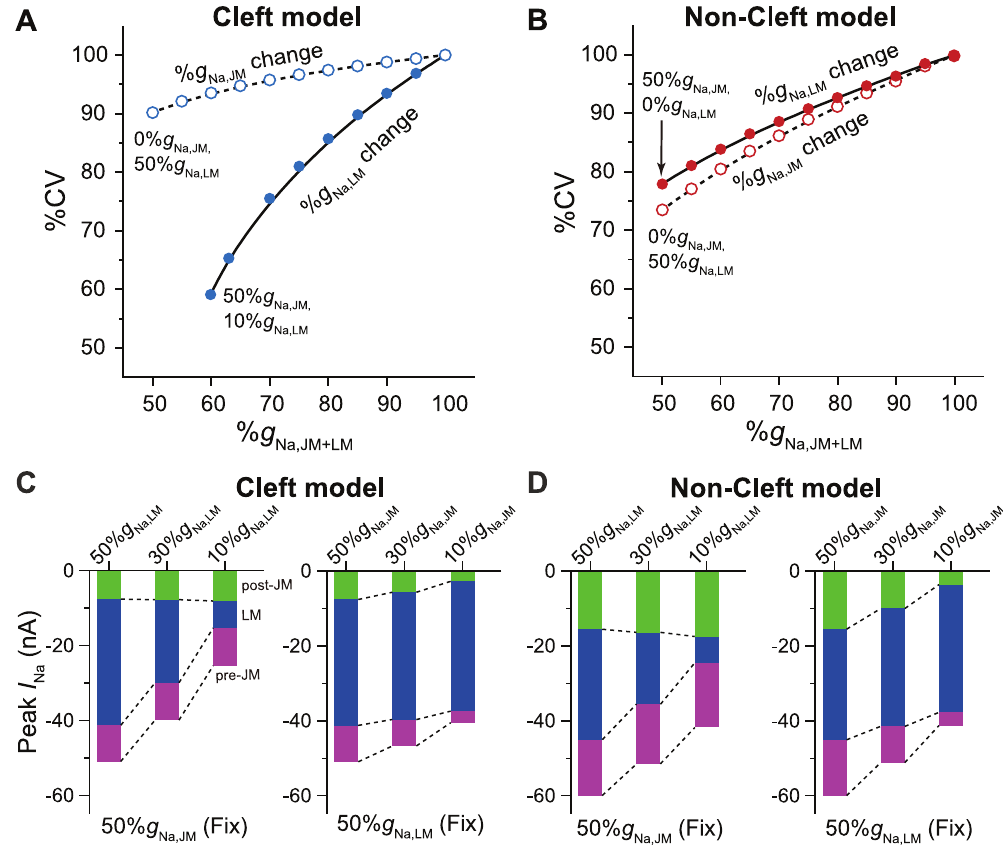
Figure 2. Conduction velocities and changes in regional I Na in cardiomyocytes in each myofiber model. (A) and (B), Relative ratios of CV (%CV) normalized by CV in the myocardial fiber with 50% g Na,JM and 50% g Na,LM as a function of % g Na,JM or % g Na,LM in the cleft (A) and non-cleft (B) models. (C), Peak values of post-junctional I Na (post- I Na,JM ), pre-junctional I Na (pre- I Na,JM ), and lateral I Na ( I Na,LM ) in a myocyte in the cleft model in which the Na + channels are fixed at 50% g Na,JM with 50% g Na,LM , 30% g Na,LM , or 10% g Na,LM ( left ) and at 50% g Na,LM with 50% g Na,JM , 30% g Na,JM , or 10% g Na,JM ( right ). (D), Peak values of post- I Na,JM , pre- I Na,JM , and I Na,LM in a myocyte in the non-cleft model with 50% g Na,JM and 50% g Na,LM , 30% g Na,LM , or 10% g Na,LM ( left ), and 50% g Na,LM with 50% g Na,JM , 30% g Na,JM , or 10% g Na,JM ( right ). The peak values of I Na in each membrane segment were measured in the middle of the myofiber.